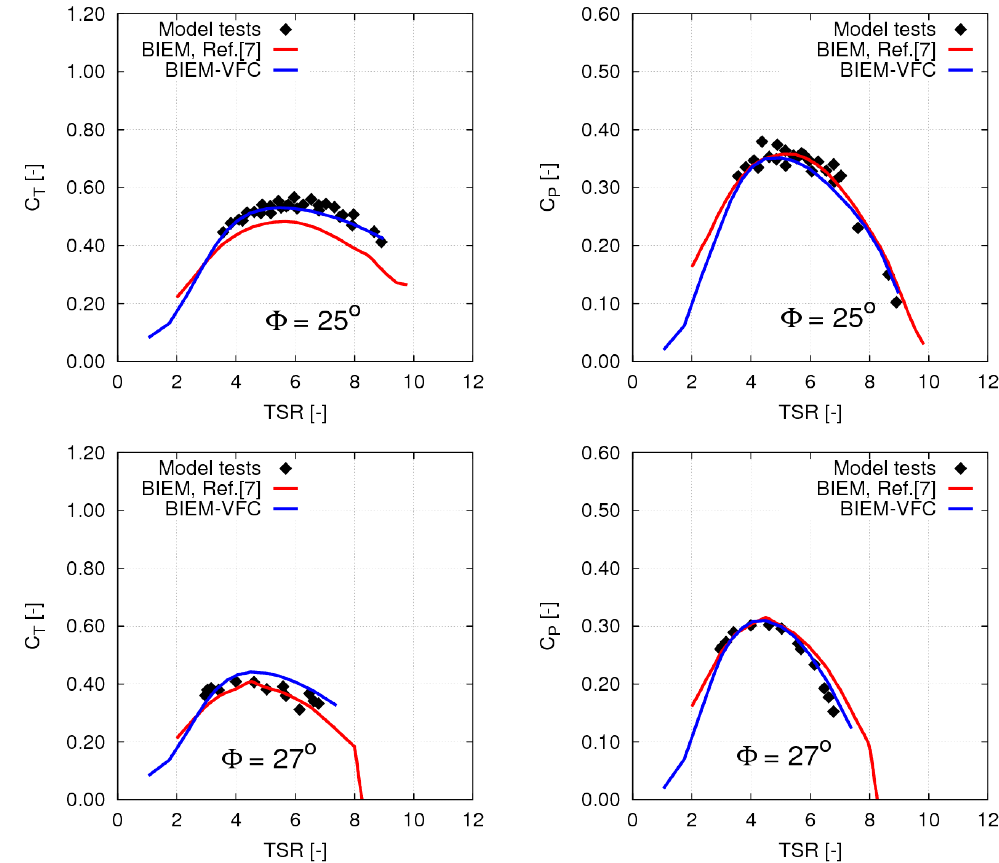
Figure 30. UoS-VP turbine performance predictions by BIEM-VFC compared to results from the BIEM model in [7]: thrust coefficient C ( left ); and power coefficient C ( right ). Pitch settings Φ = 20 ◦ to 27 ◦ T P